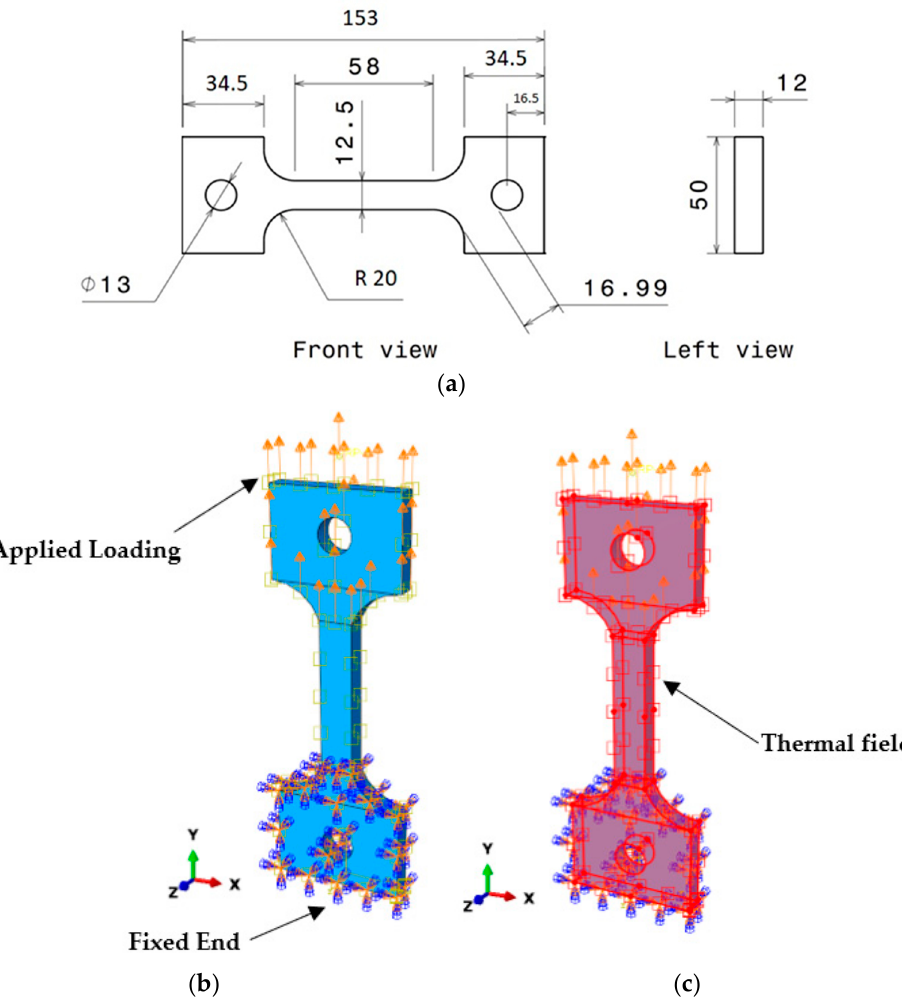
Figure 3. ( a ) Standard dimensions (in mm) of dog-bone specimen, ( b ) SS-304 specimen with pre- defined boundary conditions, ( c ) specimen with pre-defined temperature of 720 °C, which was constant throughout the